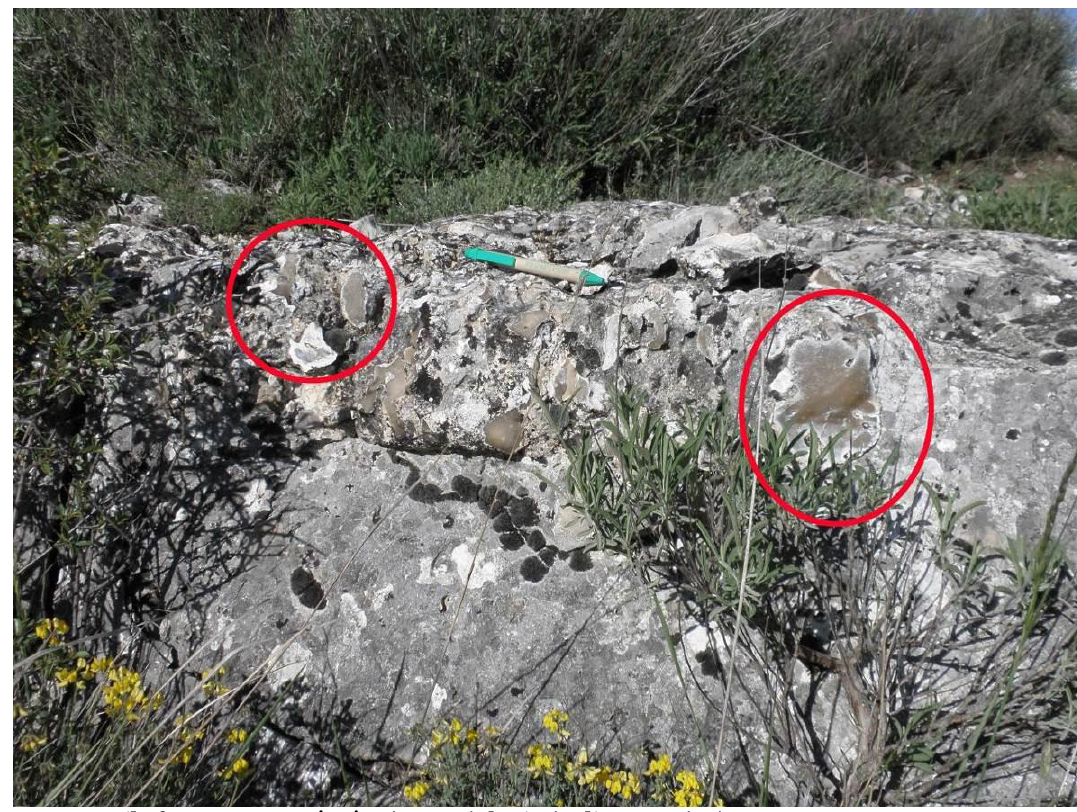
Figure 6. Detail of Las Canteras: in situ chert nodules in the limestone bed.